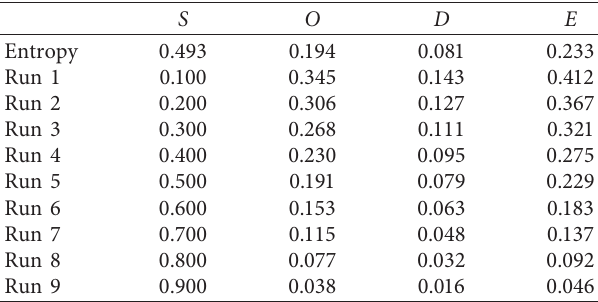
Table 8: All the risk element weights change according to severity.